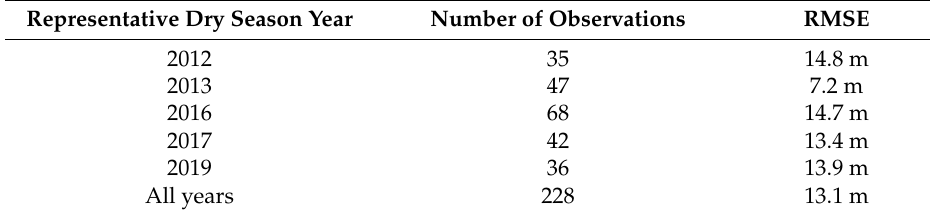
Table 4. Shoreline accuracy using Google Earth reference